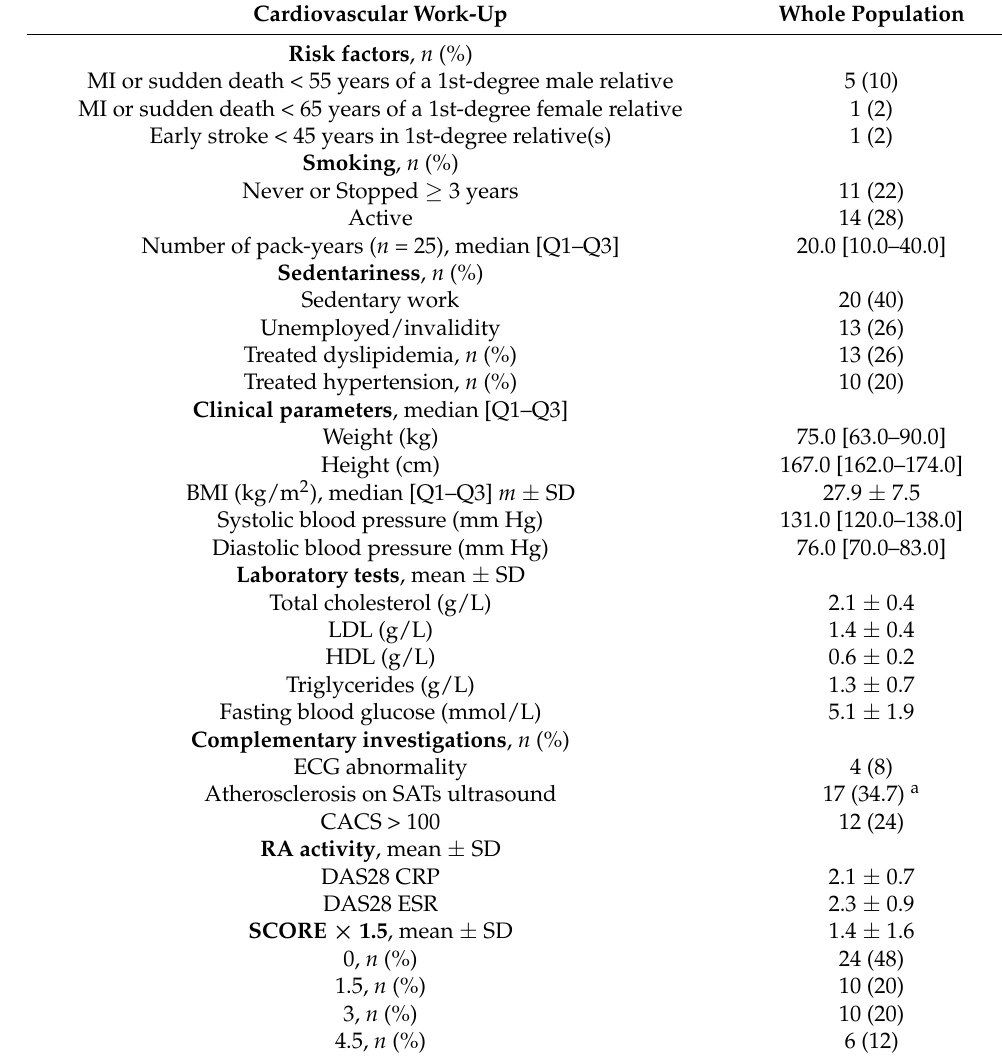
Table 2. Cardiovascular assessment results for the 50 rheumatoid arthritis patients. Cardiovascular